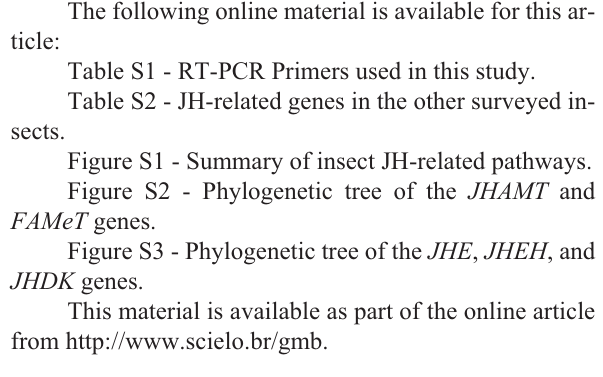
Table S1 - RT-PCR Primers used in this study. Table S2 - JH-related genes in the other surveyed in- sects. Figure S1 - Summary of insect JH-related pathways. Figure S2 - Phylogenetic tree of the JHAMT and FAMeT genes. Figure S3 - Phylogenetic tree of the JHE , JHEH , and JHDK